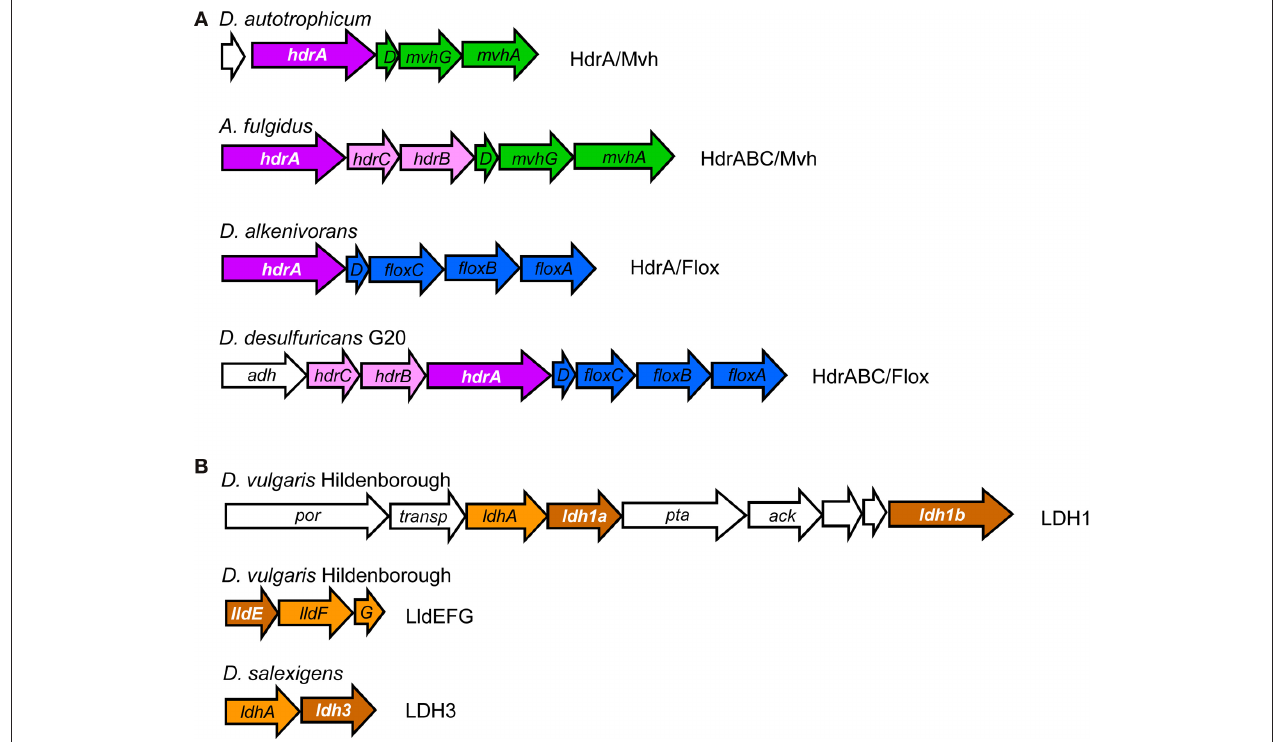
FiguRE 4 | Examples of gene loci for (A) hdrA -related genes (in white lettering) and (B) hdrD -related genes (in white